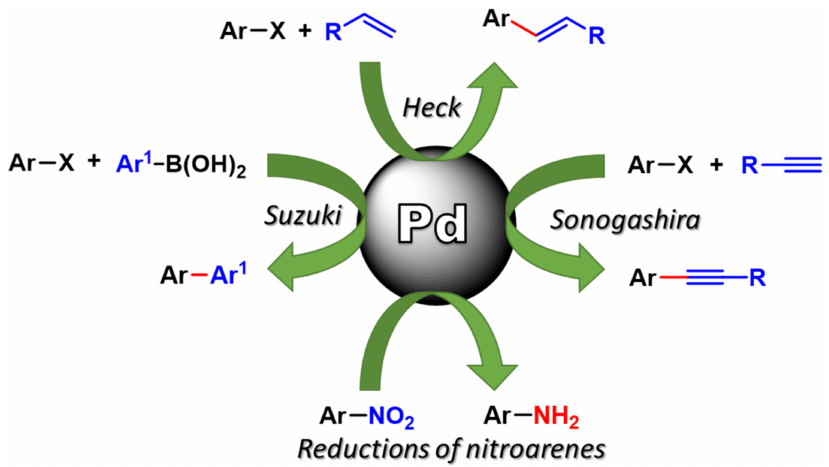
Figure 2. Synthetic application for PdNPs